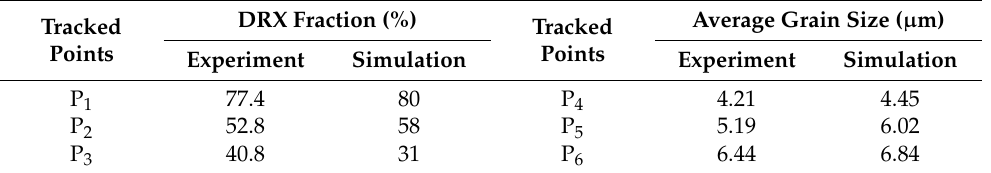
Figure 24. The simulated X drx and average grain size in key points at 1110 °C/0.1 s −1 ( a ) Distribution of the simulated X drx and average grain size; ( b ) The variation of the simulated X drx with deformation time; ( c ) The variation of the simulated average grain size with deformation time. Table 3. The comparisons of the experimental/simulated X drx and average grain size at 1110 °C/0.1 s −1 .